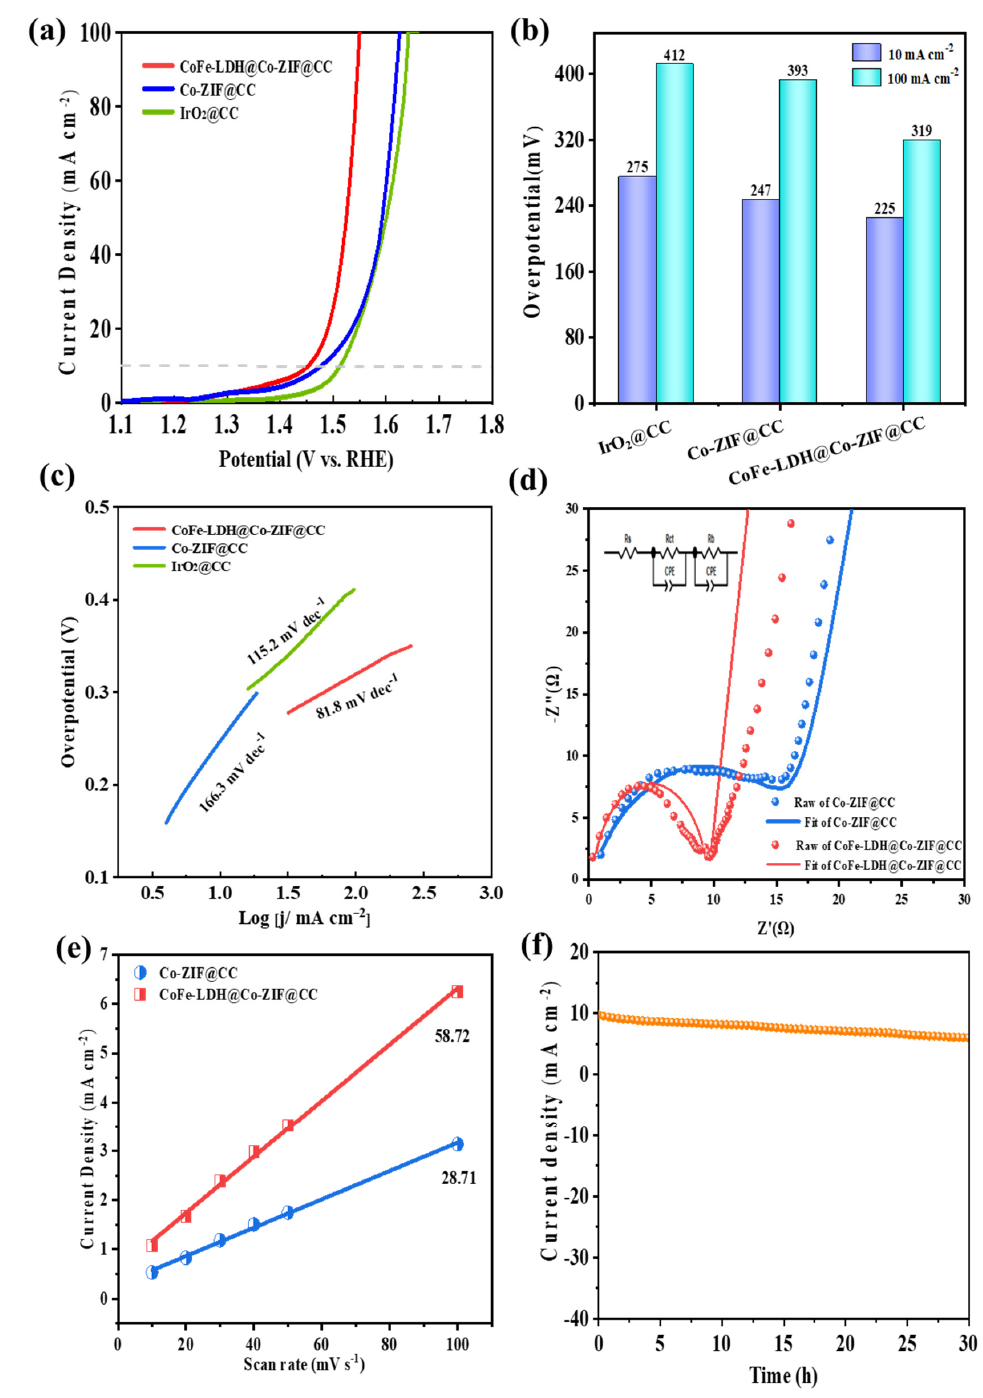
Figure 5. OER of as-prepared catalysts: ( a ) Polarization curves, ( b ) The overpotentials, ( c ) Tafel plots, ( d ) EIS spectra, ( e ) C dl values and ( f ) i-t curve of CoFe ‐ LDH@Co ‐ ZIF@CC. To further investigate the inherent characteristics that cause such excellent OER catalytic activity, the electrochemical surface area (ECSA) for the abovementioned catalysts was measured through electrochemical double ‐ layer capacitance (C dl ). The